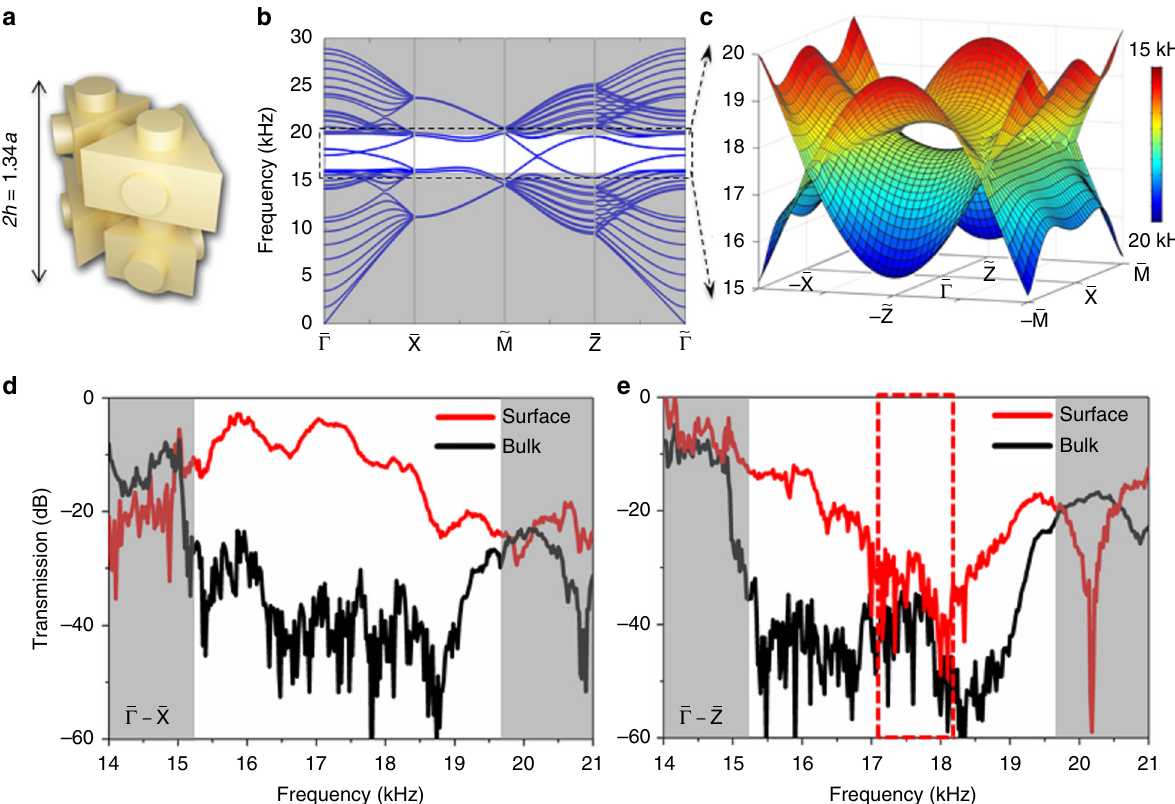
Fig. 4 Hyperbolic behaviour for the acoustic topological pseudospin-valley states. a The unit cell with increased height. b Numerical results for the projected band structures along the high symmetric directions of the surface BZ. c Zoom-in 3D view of the surface states in an eye shape. d , e Experimental transmission spectra along the ~ Γ – ~ X and ~ Γ – ~ Z directions, respectively. Dashed box represents the frequency region of the eye. The shadow regions indicate the bulk pass